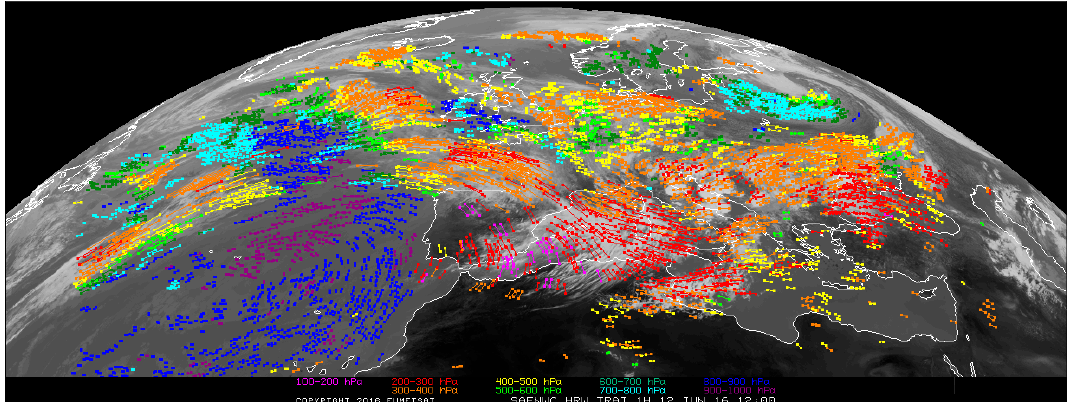
Figure 2. NWC/GEO-HRW output example of 1-h trajectories in the European and North Atlantic region, considering the default conditions for processing (12 June 2016, 12:00 UTC, MSG-3 satellite). Color coding based on the AMV pressure.